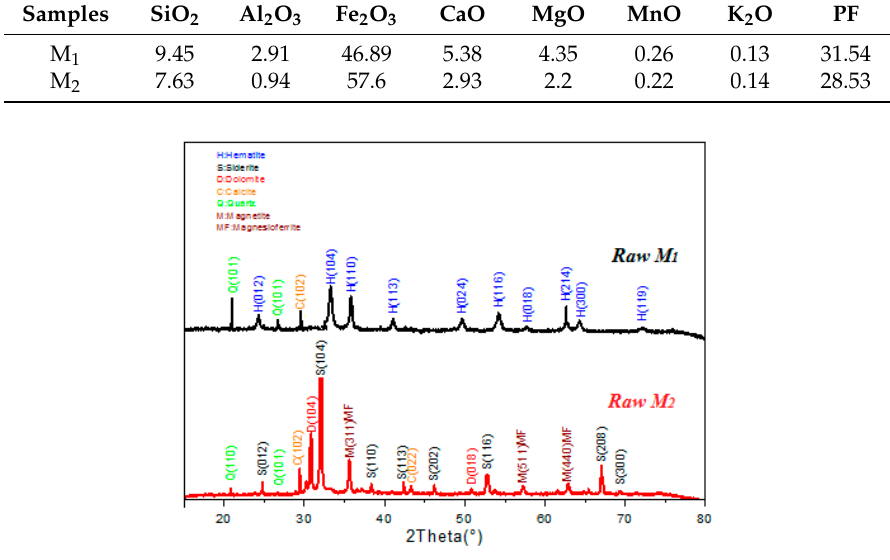
Table 1. Chemical composition (percent oxides, X-ray fluorescence) of the two raw materials. Table 2. Textural properties of the two raw materials.